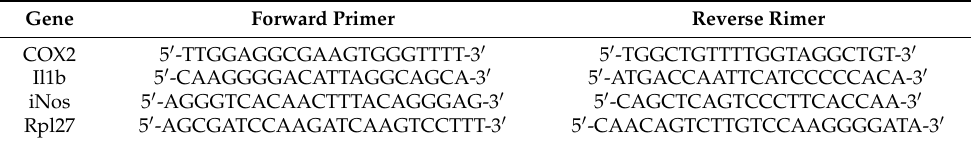
Table 6. Primer sequences used for gene amplification in the LPS-induced inflammation model. Gene